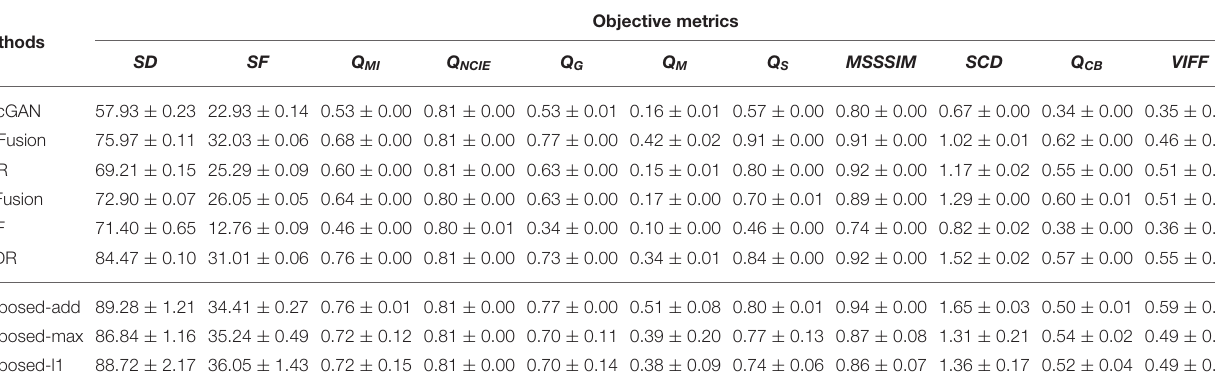
TABLE 5 | The quantitative evaluation of different comparison methods on the MRI-PET dataset.